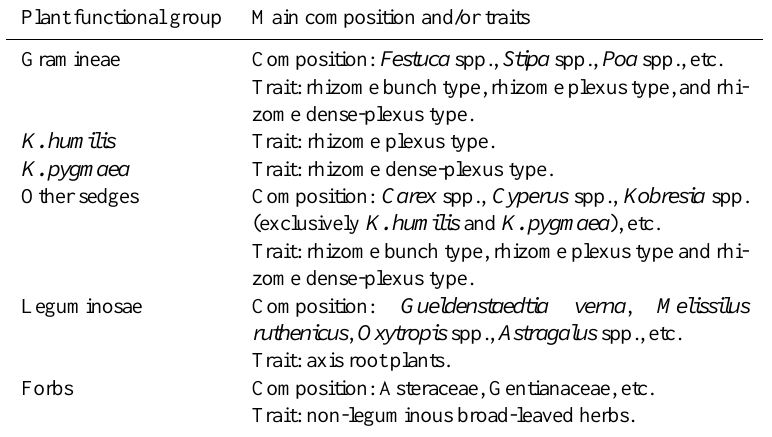
Table 2. Plant functional groups and their composition or traits. Plant functional group Main composition and/or traits Gramineae Composition: Festuca spp., Stipa spp., Poa spp., etc. Trait: rhizome bunch type, rhizome plexus type, and rhi- zome dense-plexus type. K. humilis Trait: rhizome plexus type. K. pygmaea Other sedges Composition: Carex spp., Cyperus spp., Kobresia spp. (exclusively K. humilis and K. pygmaea ),